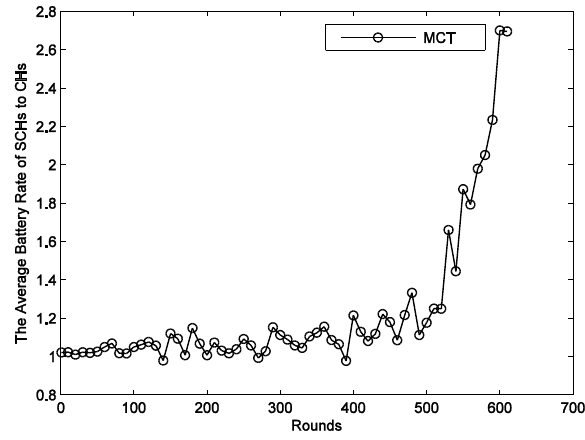
Figure 13. Average battery rate of SCHs to CHs.